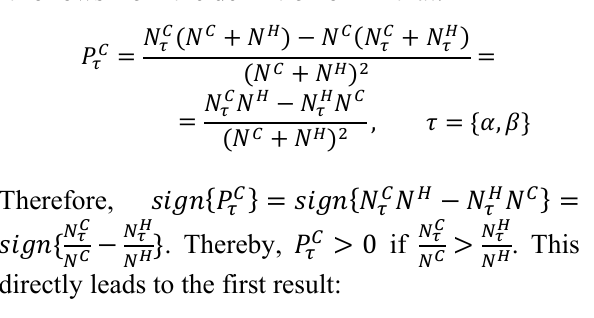
(cid:3009) (cid:3010)(cid:3004) (cid:3009) (cid:3004) (cid:1840) (cid:3398) (cid:1840) (cid:3010) (cid:1840) (cid:3004) (cid:3009) (cid:2870) (cid:4666)(cid:1840) (cid:3397) (cid:1840) (cid:4667) (cid:3010)(cid:3004) (cid:3009) (cid:3010)(cid:3004) (cid:3009) (cid:3004) (cid:3423) (cid:3404) (cid:1871)(cid:1861)(cid:1859)(cid:1866)(cid:4668)(cid:1840) (cid:1840) (cid:3398) (cid:1840) (cid:3010) (cid:1840) (cid:4669)